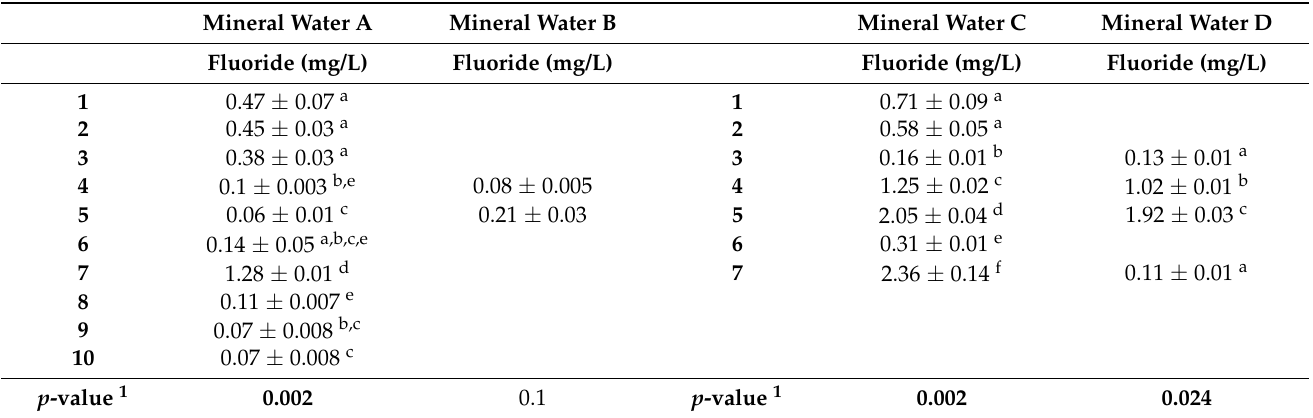
Table 2. Characterization of fluoride content (mean ± SE) in bottled water from the four